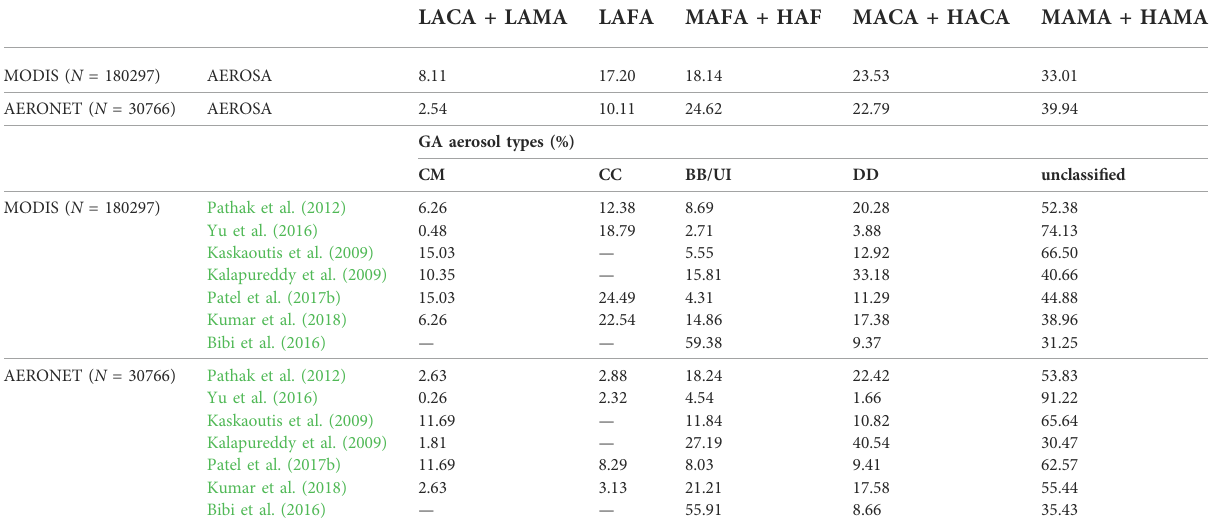
TABLE 9 Comparison between the aerosol classi fi cation results using the AEROSA and GA methods over Pakistan using MODIS data from March 2000 to February 2018 and AERONET data from 2007 to 2014.